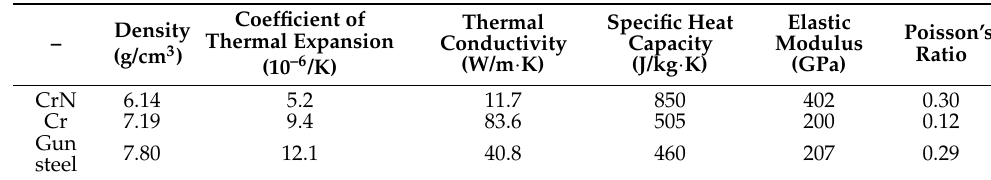
Table 1. The thermodynamic parameters of gun barrel and coating materials.